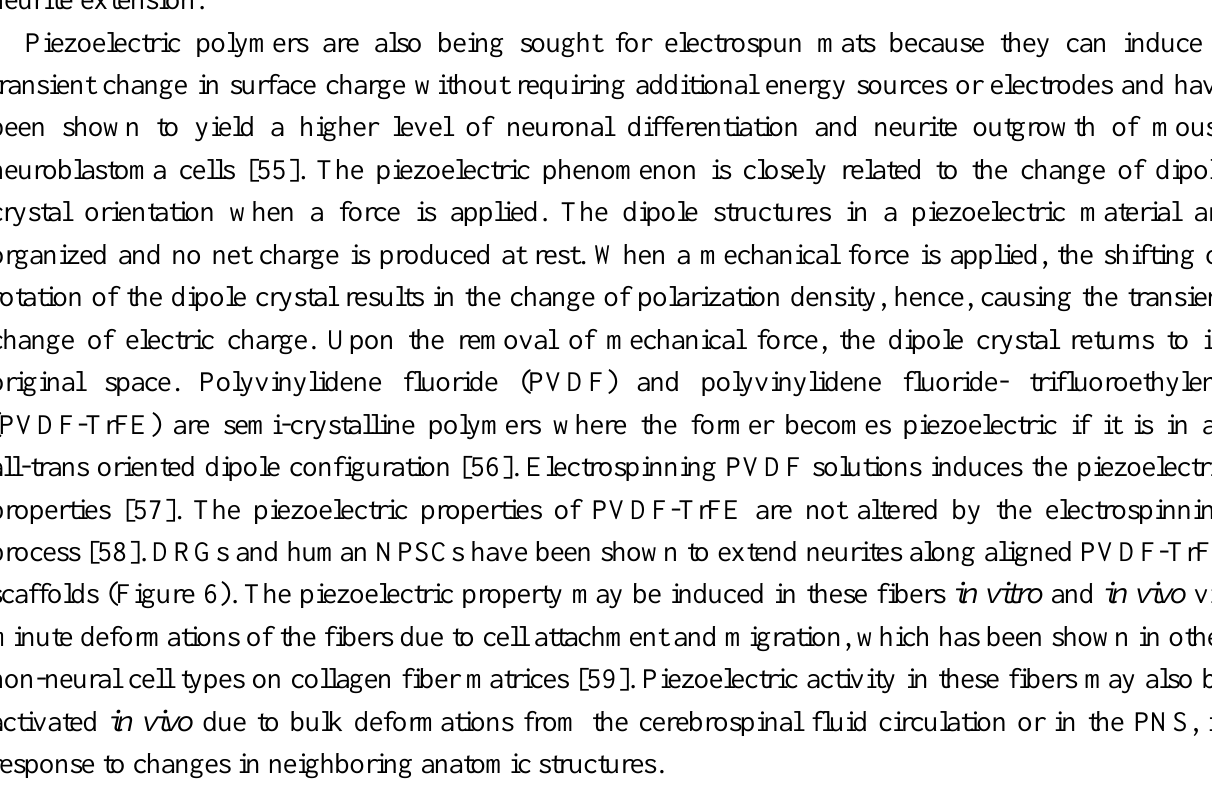
Figure 6. Confocal fluorescent images of: ( A ) DRGs on electrospun micron- aligned PVDF-TrFE at day 4 in culture. F-actin is stained green. (4×, scale bar = 300 µm) ( B ) Human NPSCs on electrospun micron- aligned PVDF-TrFE in induction media at day 9. Cells are stained for neural stem/progenitor cell marker (nestin-green), neuron marker (β-III tubulin-red), and counter stained with a nuclear-stain (DAPI-blue) (40×, scale bar = 50